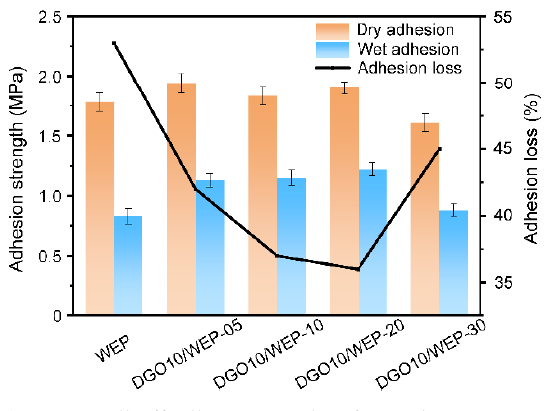
Figure 6. Pull-off adhesion results of waterborne epoxy resin coatings.